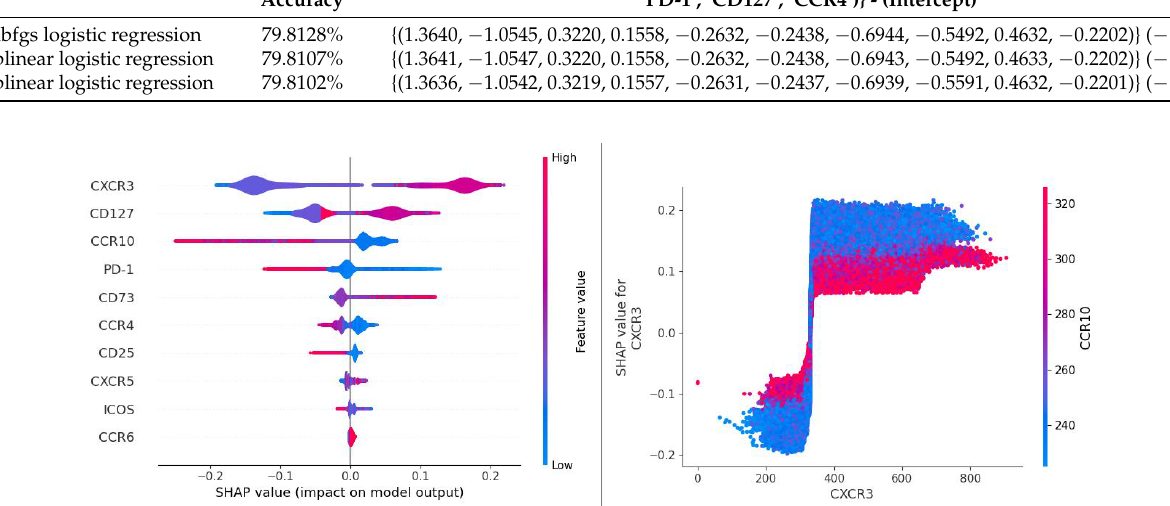
Table 6. Application of different variants of generalized linear models (Adaptive panel, Naïve CD4 cells, responders vs. nonresponders at day 1). “lbfgs” stands for limited-memory Broyden–Fletcher–Goldfarb–Shanno algorithm; “liblinear”, coordinate descent algorithm; L1, L1 regularization; L2, L2 regularization. Classification accuracy was assessed using five-fold cross-validation. Extended decimals are shown to indicate that the results were similar but not identical. Model